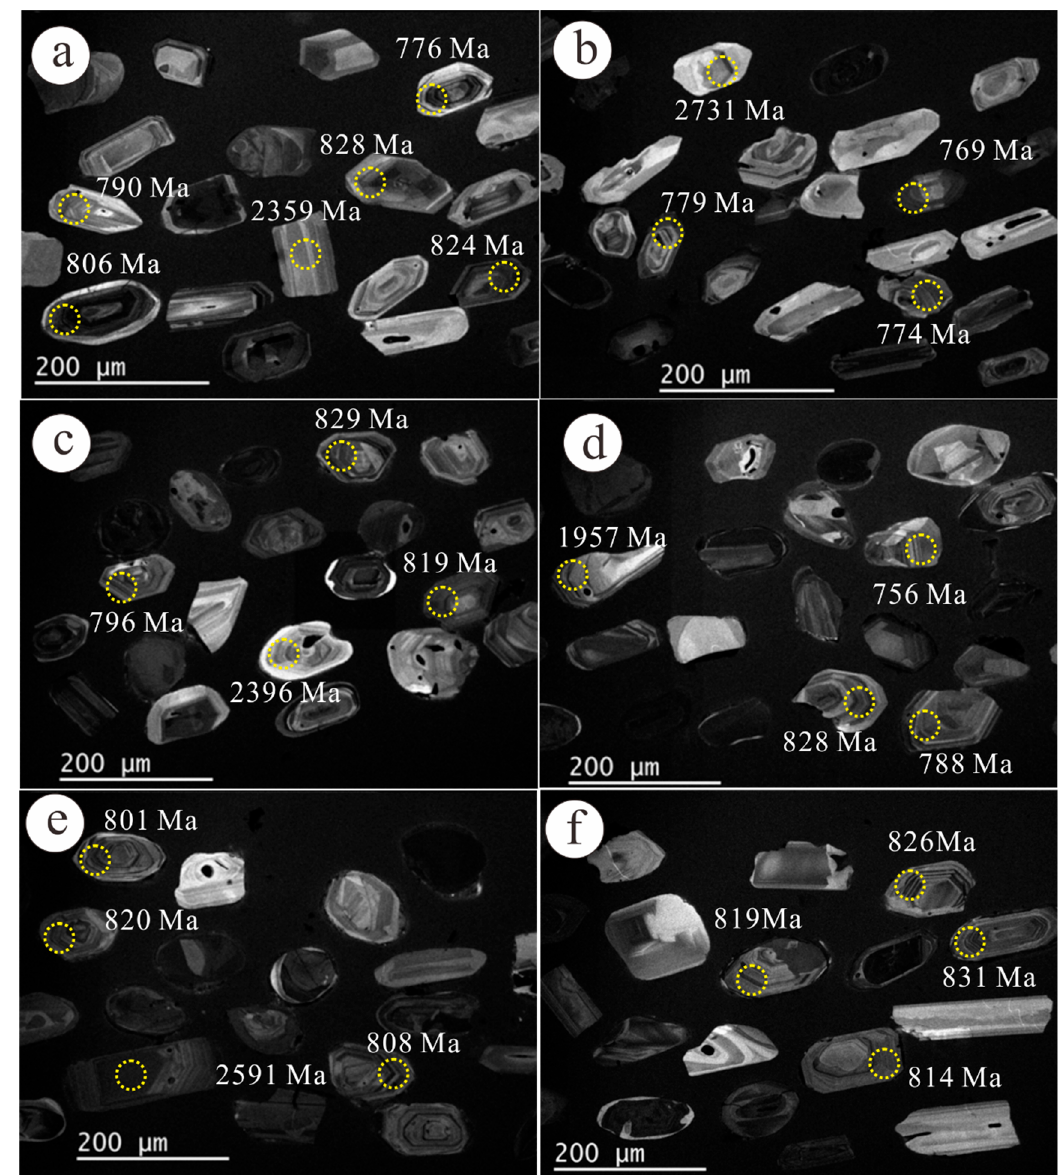
Figure 5. Cathodoluminescence (CL) images of zircon grains from the represented samples, showing the location of the spots for laser ablation-inductively coupled plasma-mass spectrometer (LA-ICP-MS) U–Pb dating. ( a ) and ( b ) are of tuffaceous slate; ( c ); and, ( d ) are of sandy slate; ( e ) and ( f ) are of gold-bearing quartz vein.